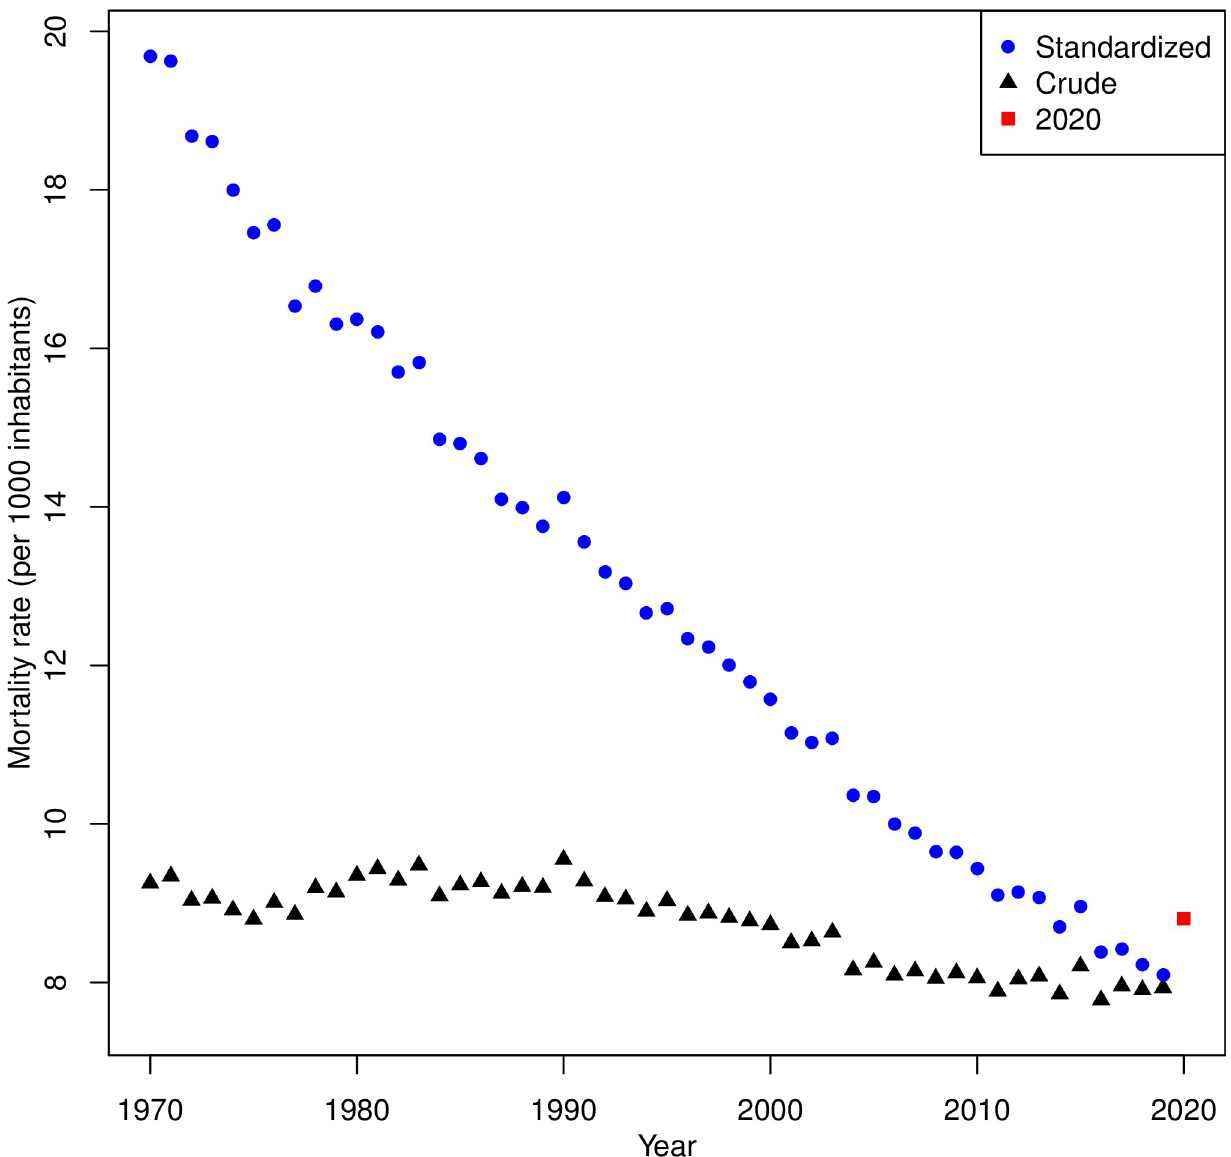
Fig 1. Crude and directly standardized mortality rates in Switzerland for the period 1970–2020 (data from the Swiss Federal Statistical Office and the Human Mortality